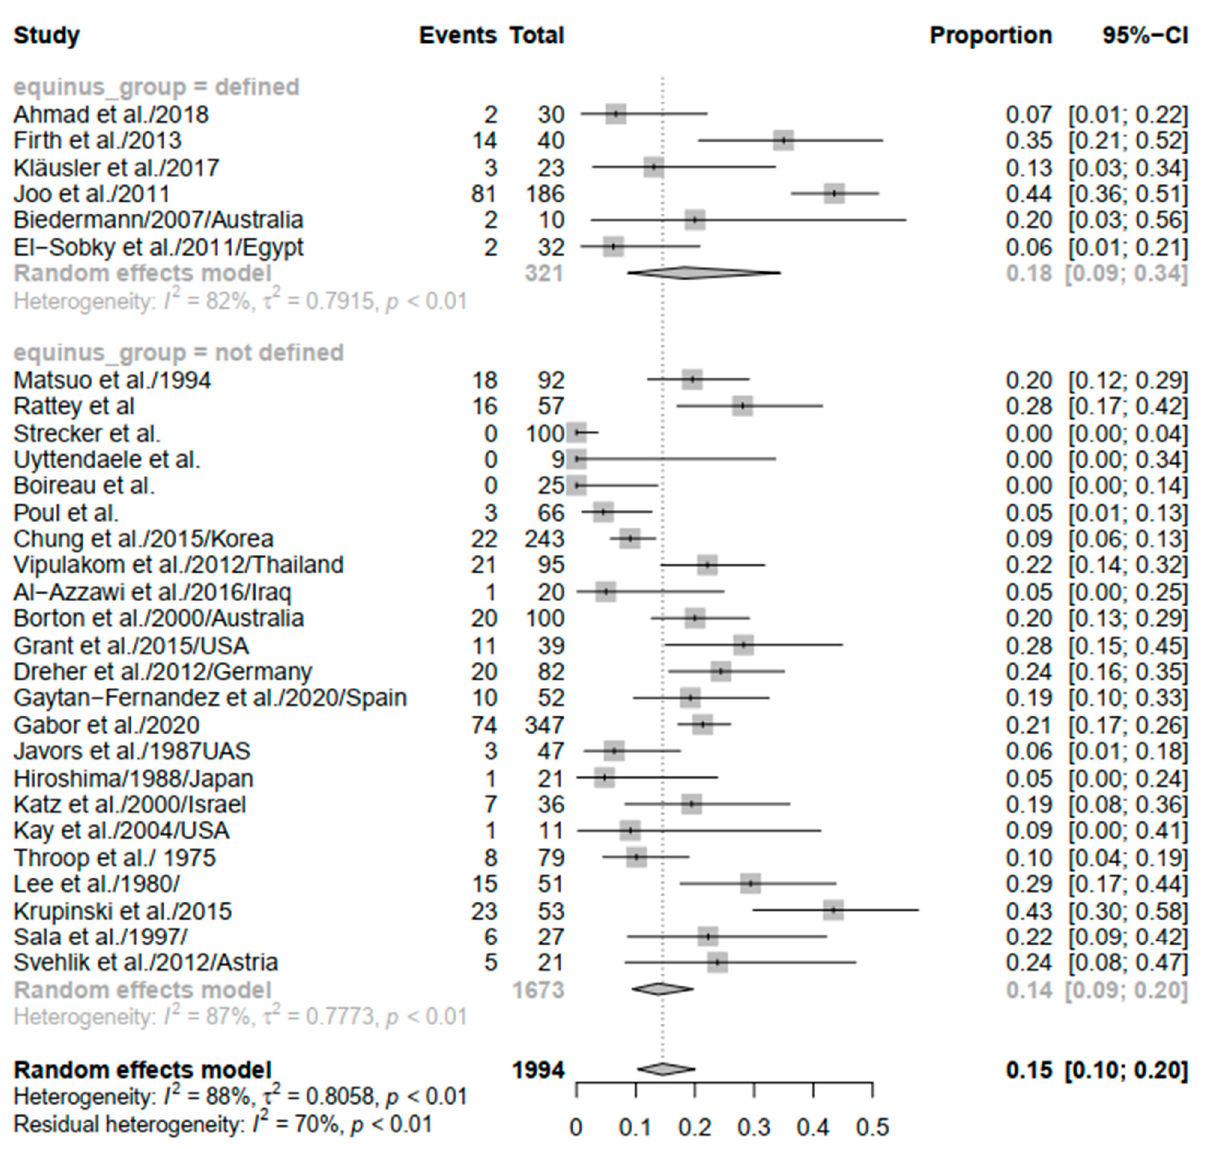
Figure 5. Forest plot of the subgroup analysis of equinus recurrence based on equinus definition.